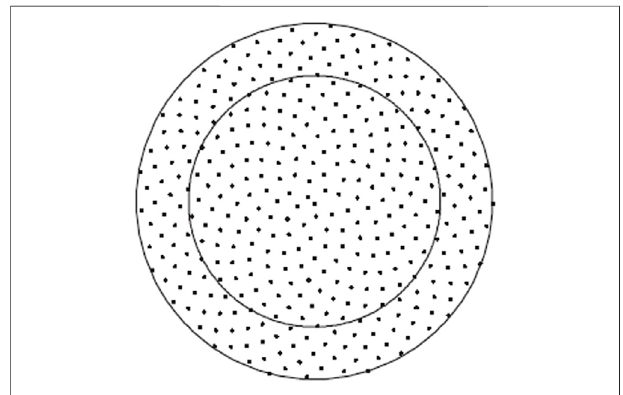
FIGURE1| Equalareanorthpoleprojectionofpointsonthesurfaceofa sphere (Hannay and Nye,